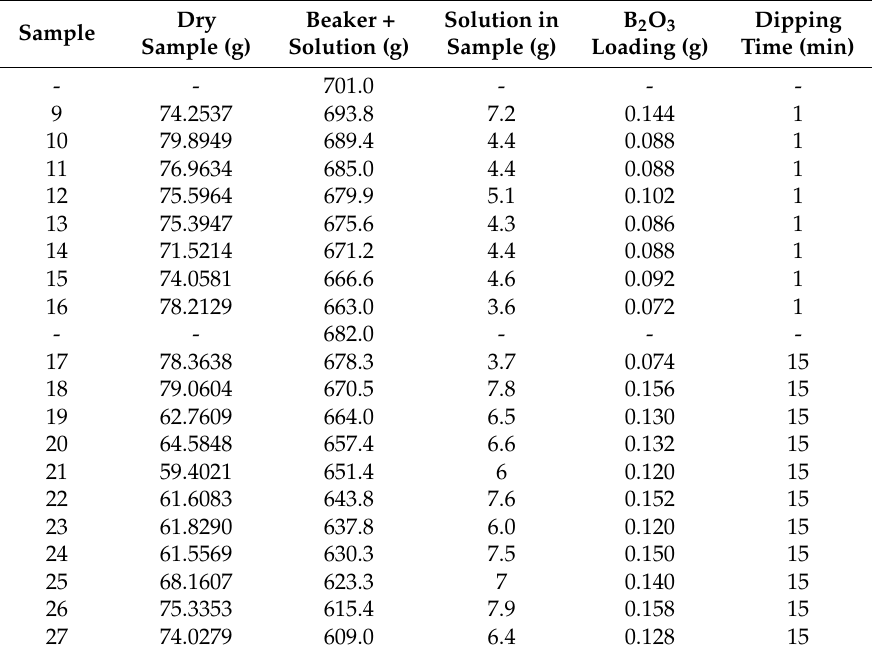
Table 4. Boron loading on impregnated